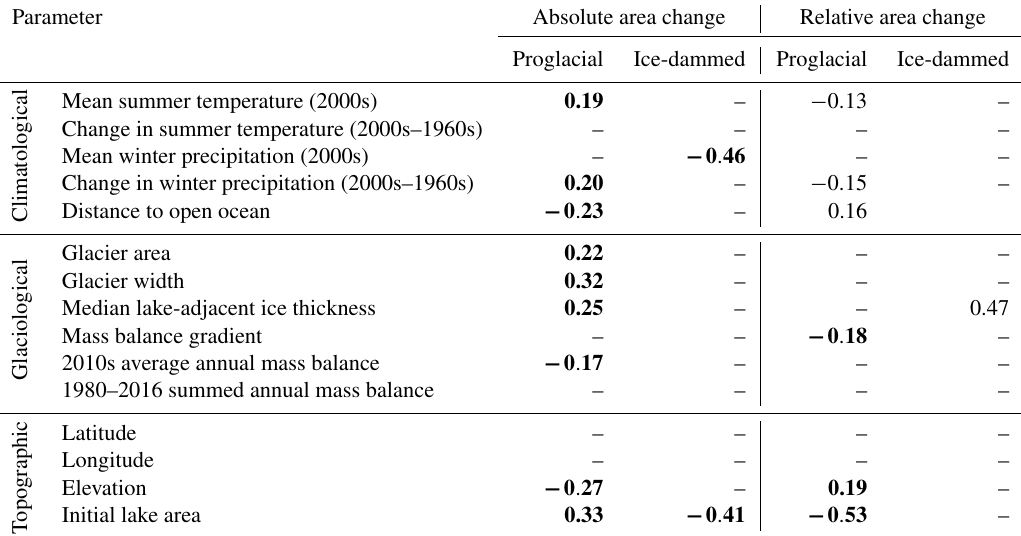
Table 3. Kendall rank correlation coefficient ( τ ) values for monotonic relationships between absolute (middle columns) and relative (right- most columns) lake area change with associated climatological, glaciological, and topographic variables. In each category, test statistics are reported separately for proglacial and ice-dammed lakes. Bold numbers indicate correlations that are significant at p ≤ 0 . 05, while regular text indicates relationships where 0 . 05 < p ≤ 0 . 1. Dashes indicate a correlation with p > 0 . 1. Positive (negative) correlation coefficients indicate a direct (inverse) relationship between the examined